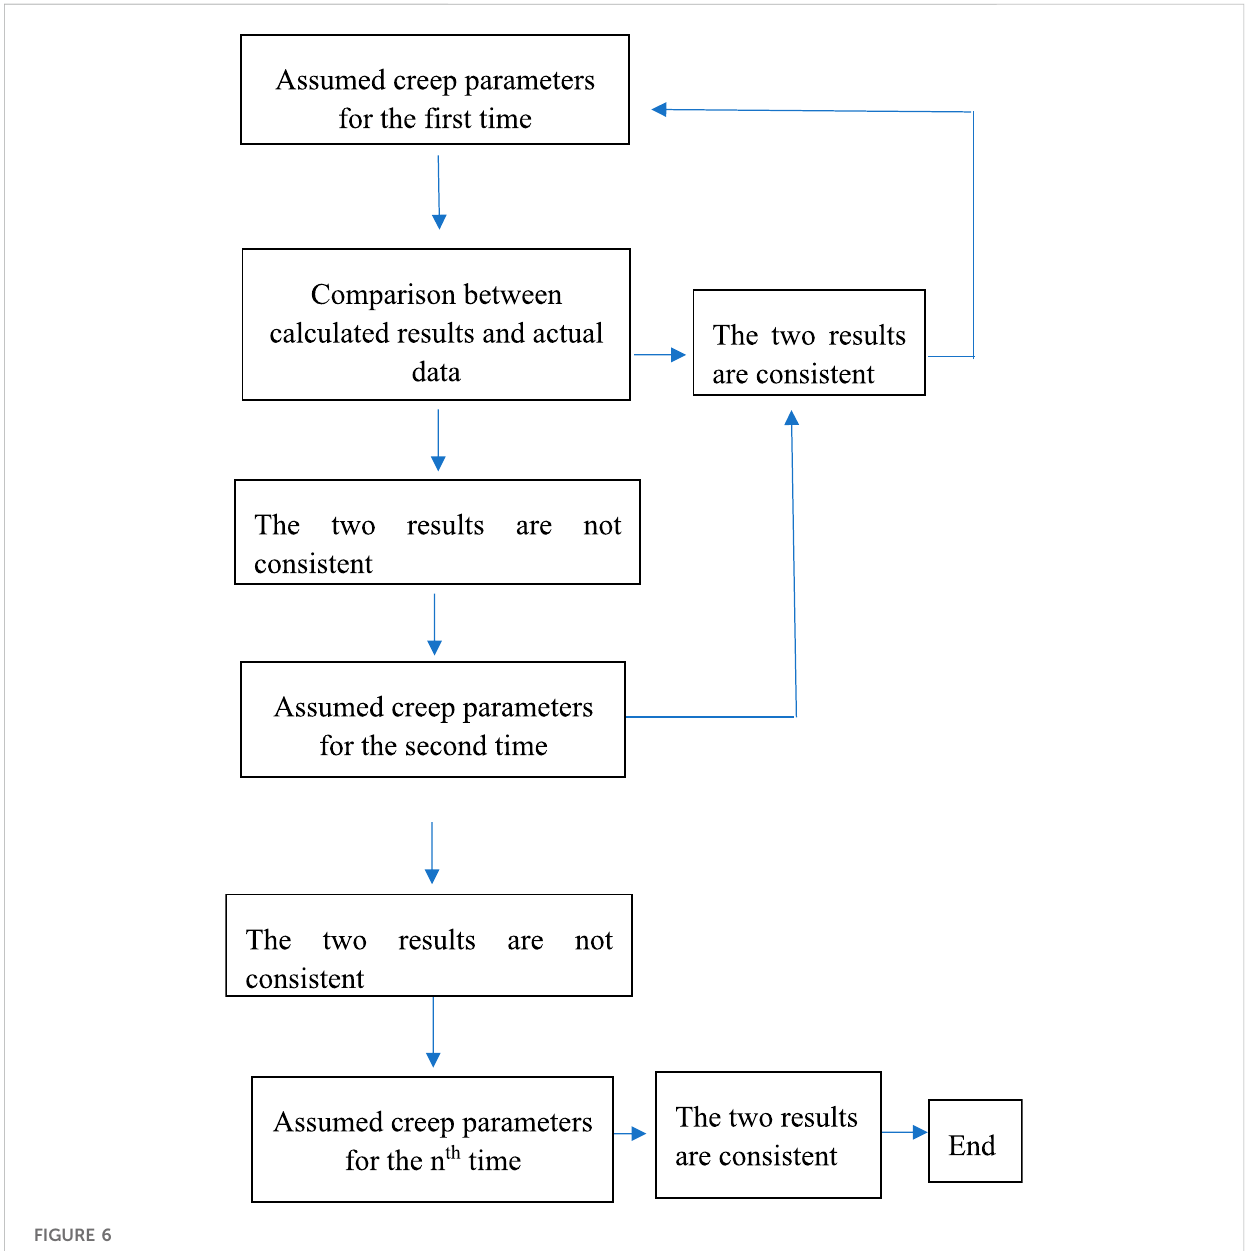
FIGURE 6 Flow chart.